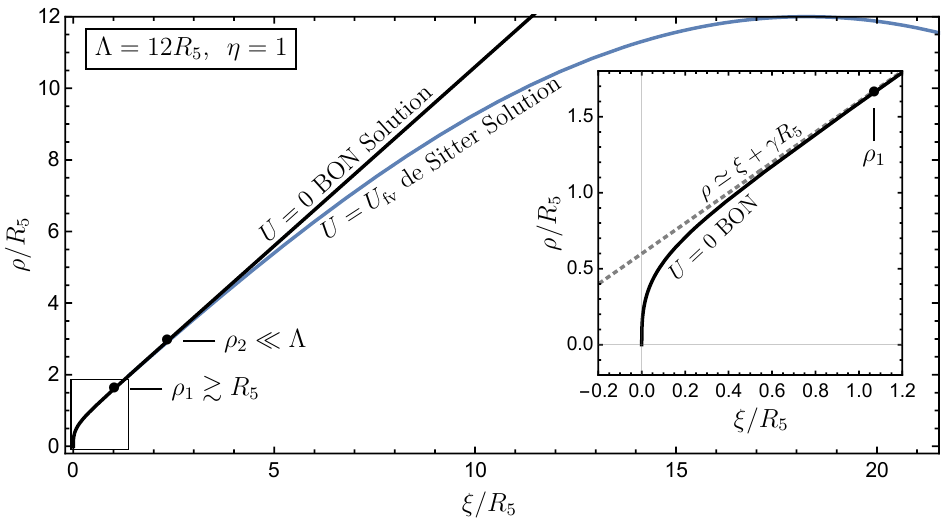
Figure 5: Diagram for ⇢